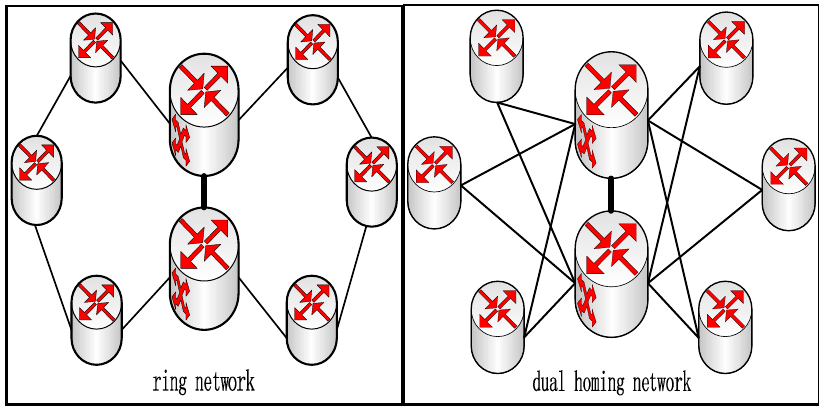
Figure 2. Different network architectures of the power communication network.